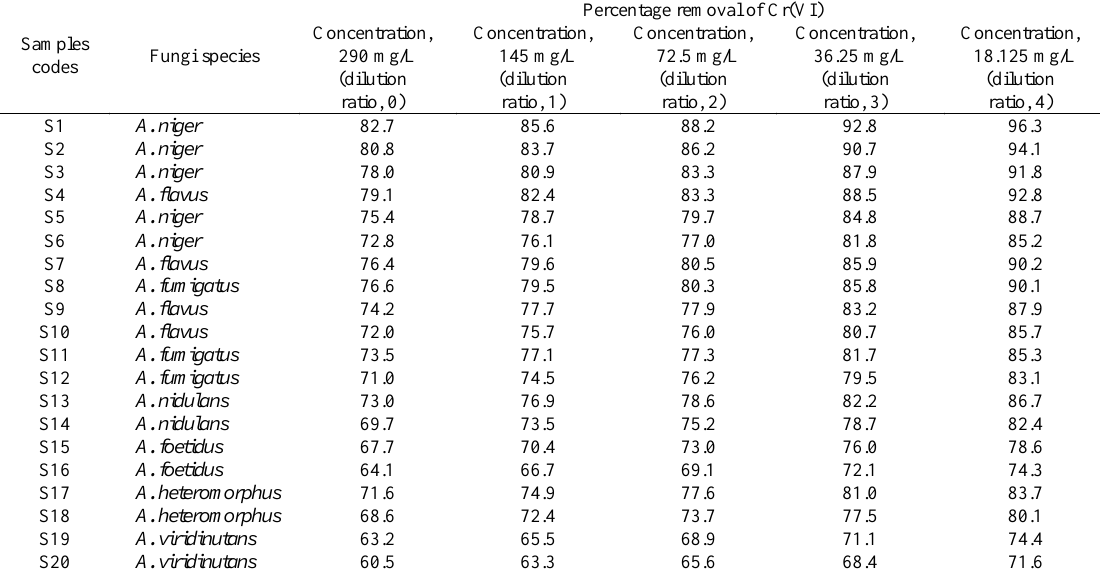
Table 6: Effect of initial Cr(VI) concentration in removal percentage of Cr(VI) in tannery industry wastewater by isolated fungi from tannery industry wastewater contaminated soil against an optimum pH of 3, optimum fungus biomass of 4.0 g